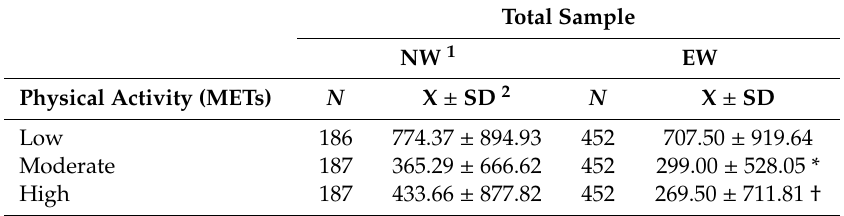
Table A2. Physical activity data distributed according to nutritional state (total sample).